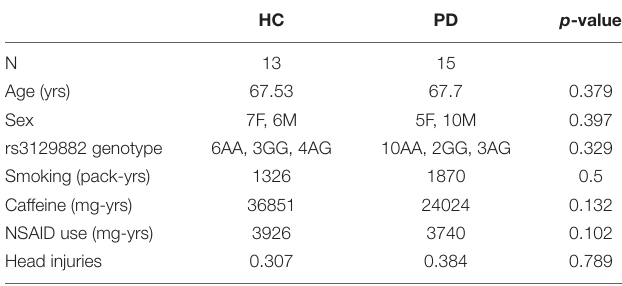
TABLE 1 | Demographics of the study